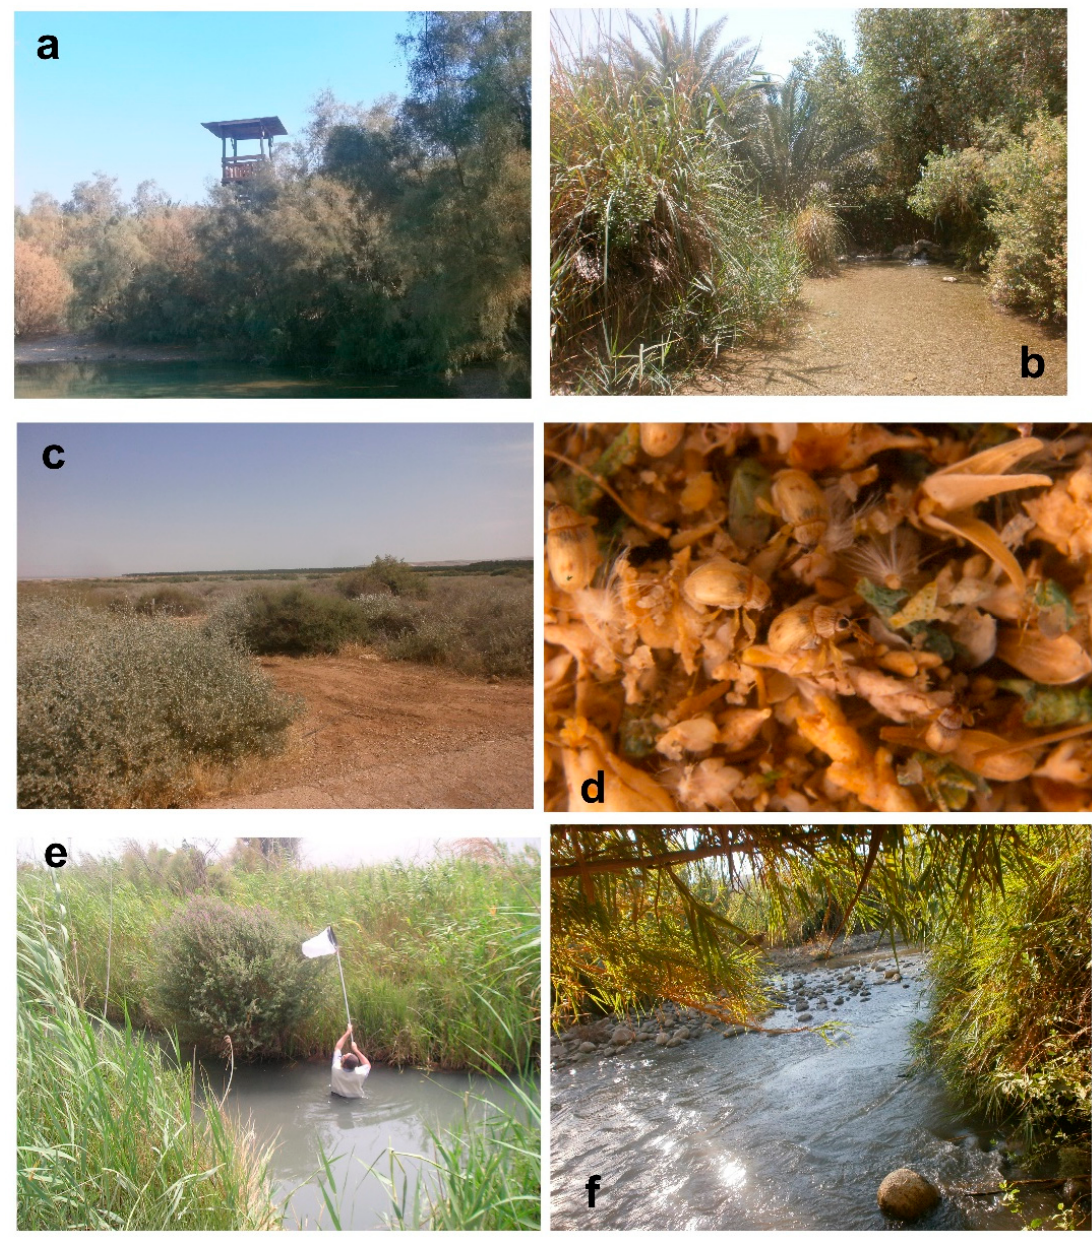
Figure 1. ( a ) Enot Zuqim Nature Reserve, oasis on the NW coast of the Dead Sea, thicket of Tamarix spp.; ( b ) same place, Arundo donax , Juncus sp., Phoenix dactylifera , Pluchea dioscoridis , Populus euphratica , Tamarix spp.; ( c ) Wadi Malha Wetland Nature Reserve, saltmarsh, Jordan Valley, in the foreground Atriplex halimus and Suaeda aegyptiaca , on the background Tamarix sp.; ( d ) Corimaliini in Tamarix litter (courtesy Amikam Shoob); ( e ) Nahal Qibbuzim, Bet She‘an Valley, the author is sweeping Nanophyini from Lythrum salicaria (photograph taken by one of the author’s children); ( f ) Park haYarden, bank of the Jordan